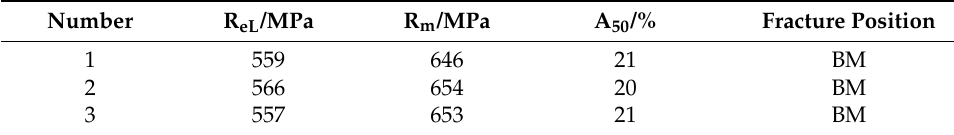
Table 3. Results of tensile test for flash-welded joint.